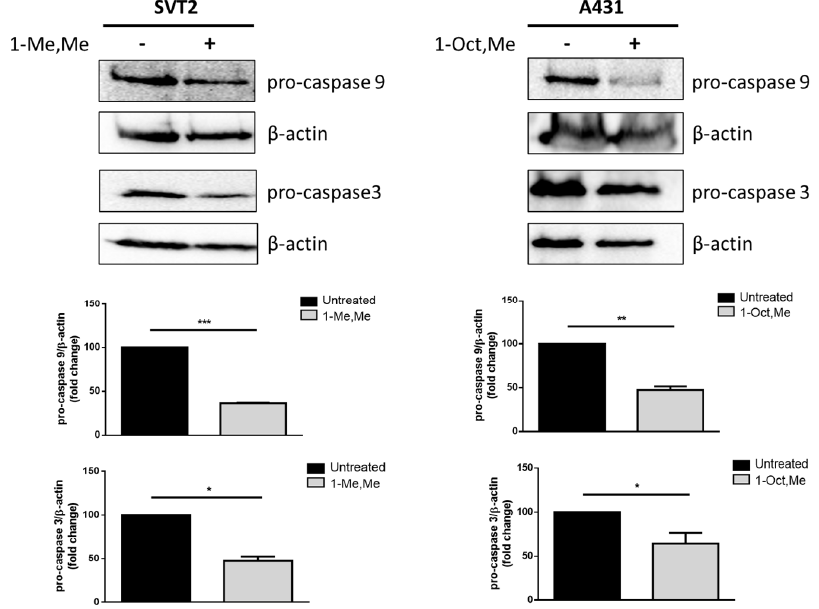
Table 3. The uptake of 1 ‐ Me,Me and 1 ‐ Oct,Me in cancer cells. Cells were incubated with either 1 ‐ Me,Me or 1 ‐ Oct,Me , with each one tested at its IC 50 value (9.8 μ M 1 ‐ Me,Me on SVT2 and 2.3 μ M 1 ‐ Oct,Me on A431). After 48 h, cells were analysed by ICP analysis, as described in the Materials and Methods section. Data shown are the means ± S.E. of three independent experiments.